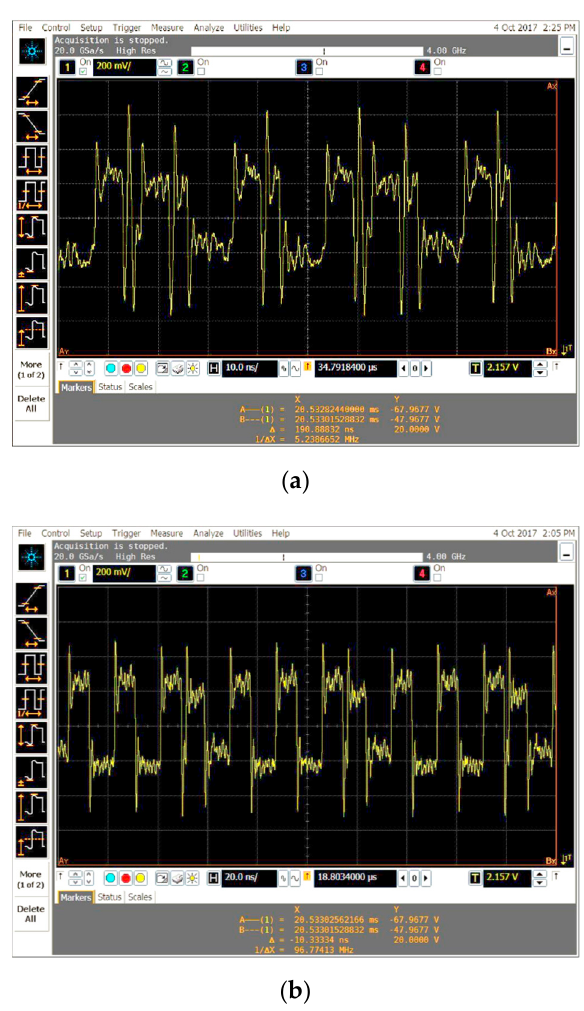
Figure 5. Examples of bit structures of TMDS signals for pixel amplitude values ( a ) 251 and ( b ) 255.